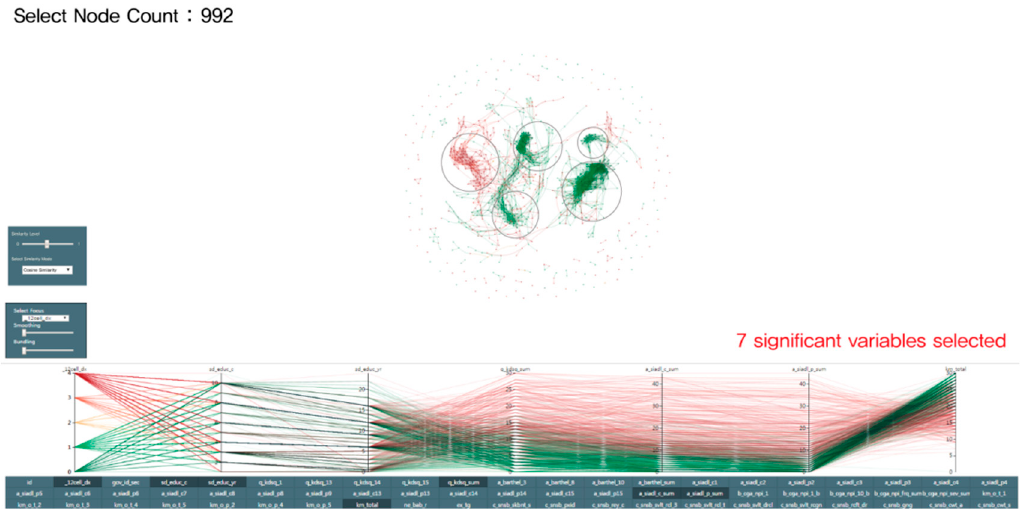
Figure 2. Previous model 1: 2D node-link diagram and Parallel Coordinates.